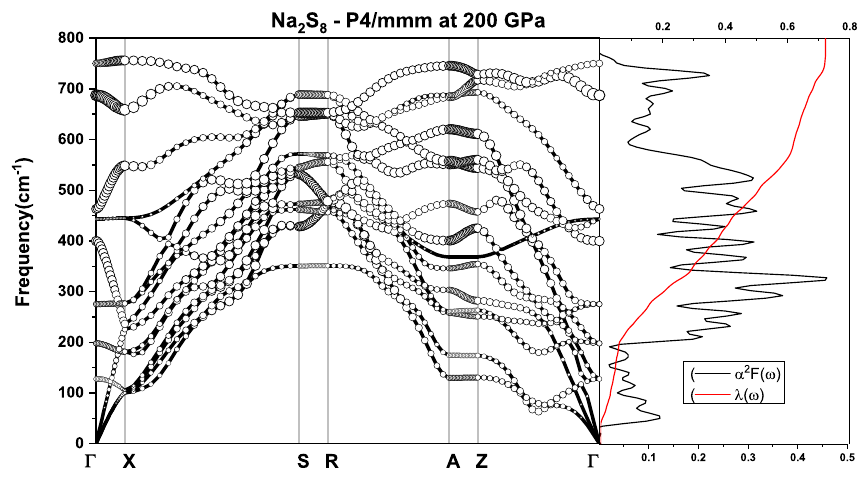
Figure 10. Phonon band structure, Eliashberg spectral function ( α 2 F ( ω ) ), and the electron phonon integral ( λ ( ω ) ) for P 4/ mmm -Na 2 S 8 at 200 GPa. Circles indicate the phonon linewidth with a radius proportional to the